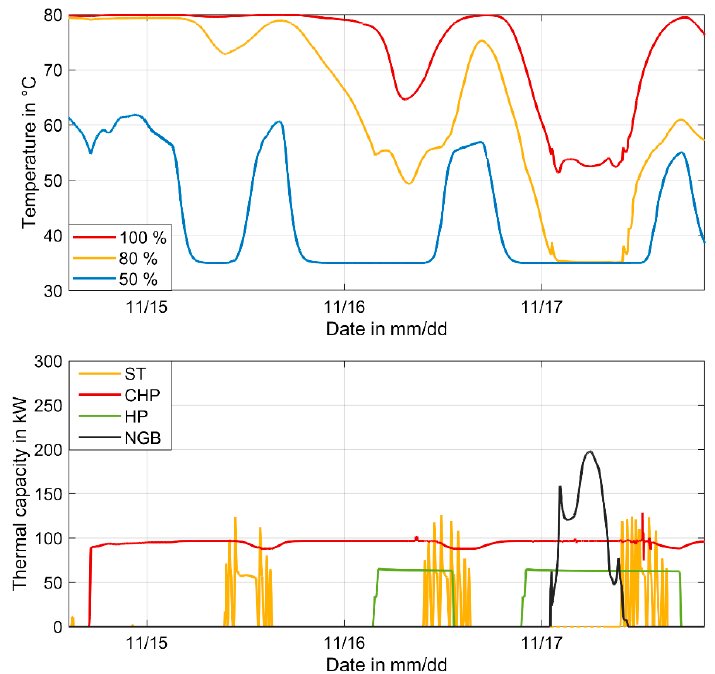
Figure 2. ( Top ): Storage temperatures for different relative storage heights (100% = top), ( Bottom ): Thermal power of the units with standard control of the local heating supply.